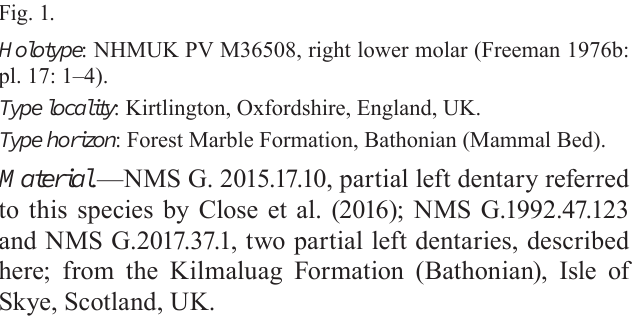
Holotype : NHMUK PV M36508, right lower molar (Freeman 1976b: pl. 17: